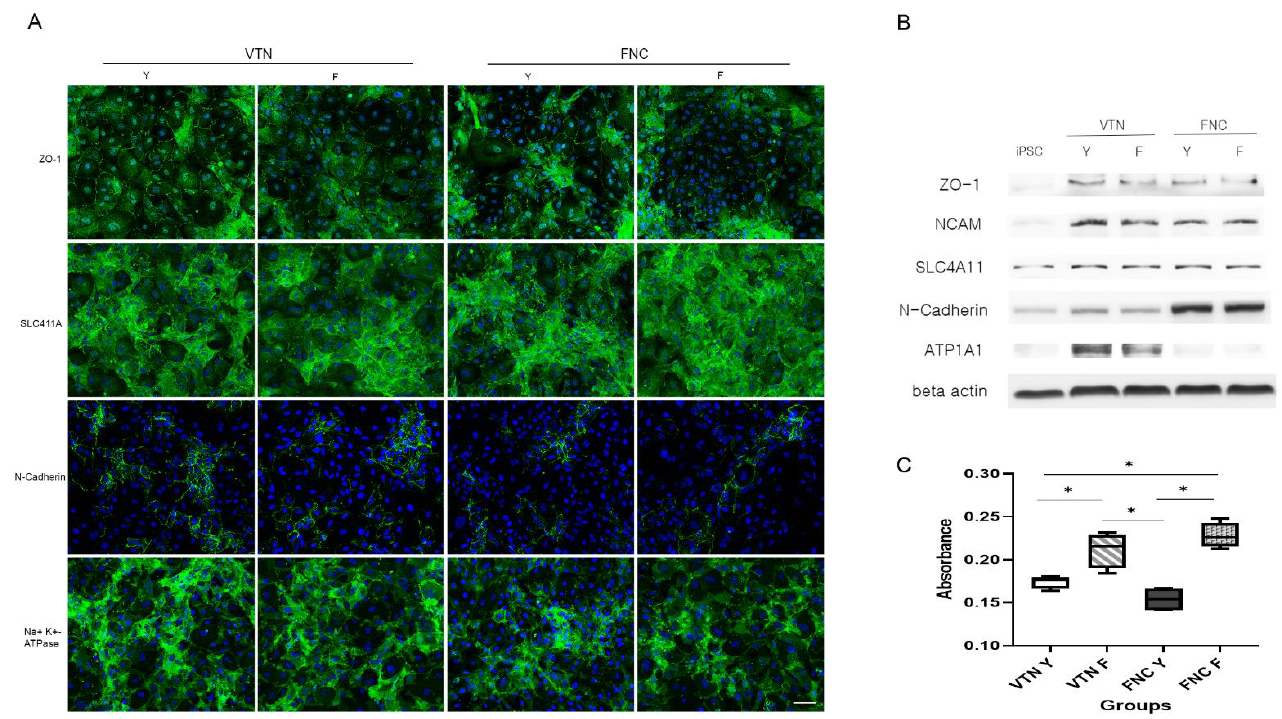
Figure 6. Comparison of different ROCK inhibitors and coating materials on CEC differentiation. ( A ) Immunocytochemistry using antibodies against ZO-1, SLC4A11, N-Cadherin, and ATP1A1. Scale bar = 50 μm for all the images. ( B ) Western blot using a group of CEC markers: ZO-1, NCAM, SLC4A11, N-Cadherin, and ATP1A1. ( C ) CCK-8 assay. Fasudil-treated groups had increased levels of cell viability and proliferation compared to Y27632-treated groups. (* p < 0.05; n = 3).